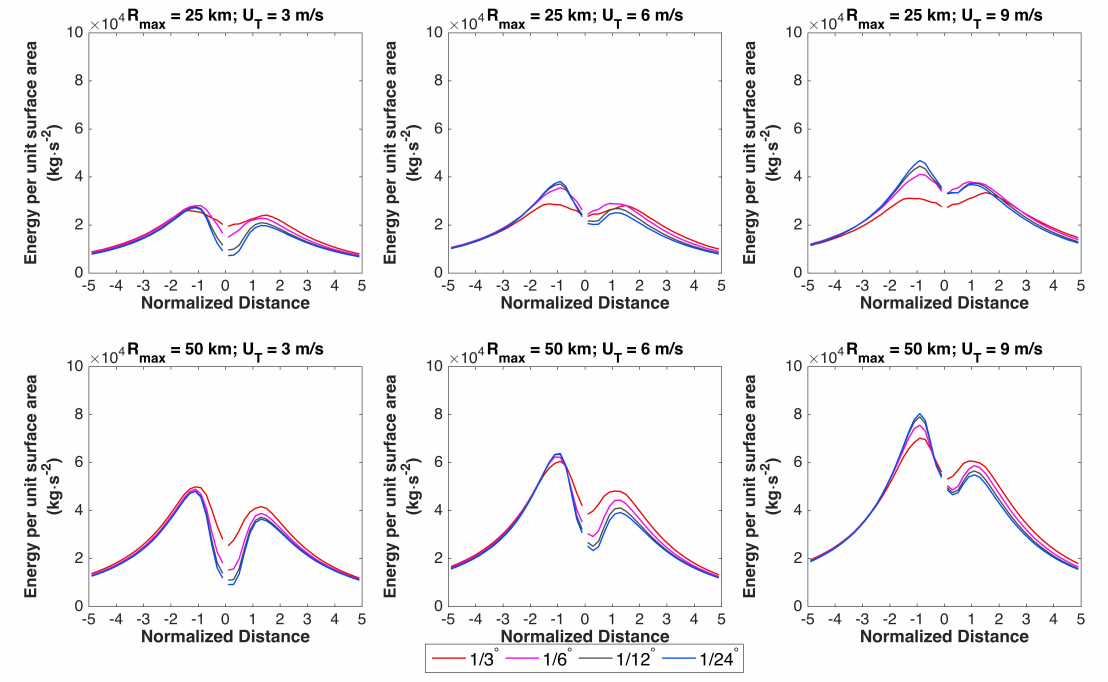
Figure 8. Average wave energy within a half-annulus area (front and rear) at different radii from the storm center under the six idealized storms from SWAN. Red, magenta, black and blue lines denote results from the coarsest to the highest